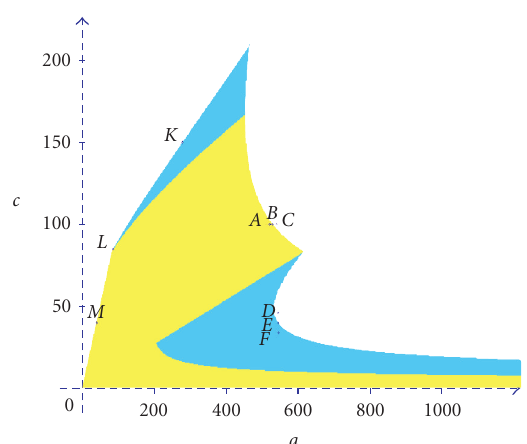
Figure 6.1 . Regions of su ffi cient stability condition and necessary and su ffi cient stability condition for (5.2): p = 0, h = 0 . 024, Δ = 0 .